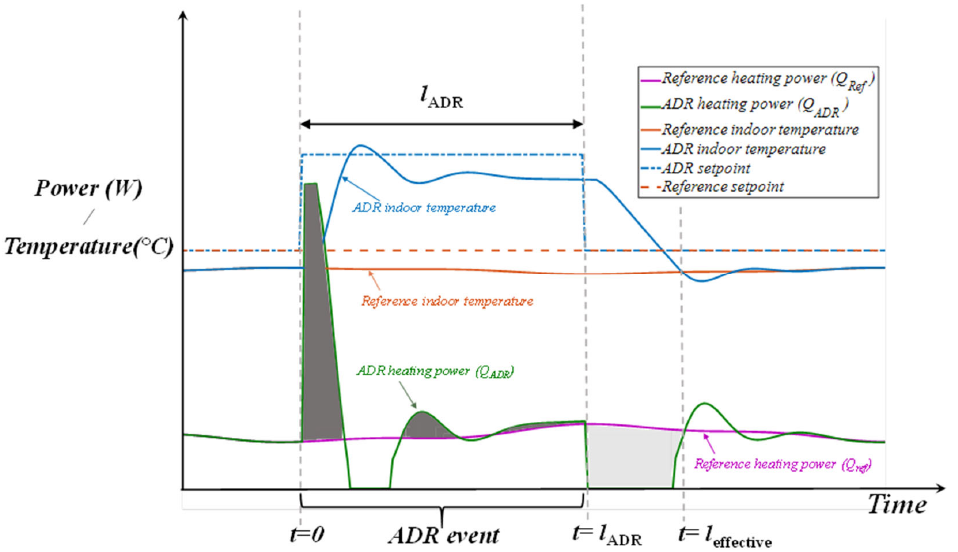
Figure 1. Conceptual representation of the measures used to quantify the available storage capacity and the storage efficiency [13].